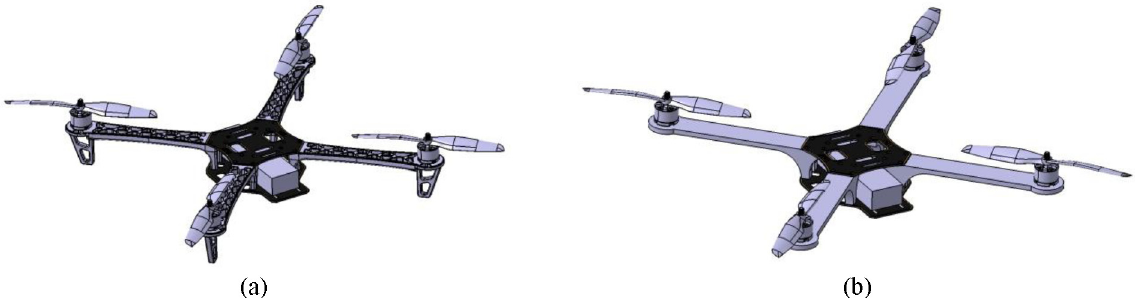
Fig. 3. Isometric view of the (a) initial drone and the (b) revised